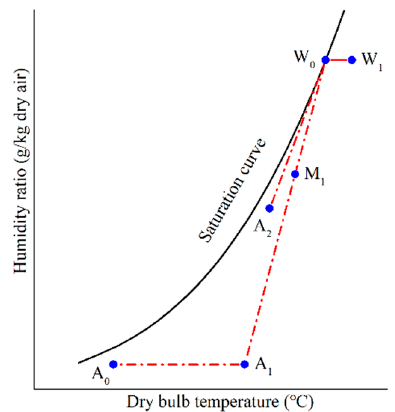
Figure 2. Schematic diagram of plume abatement technology.